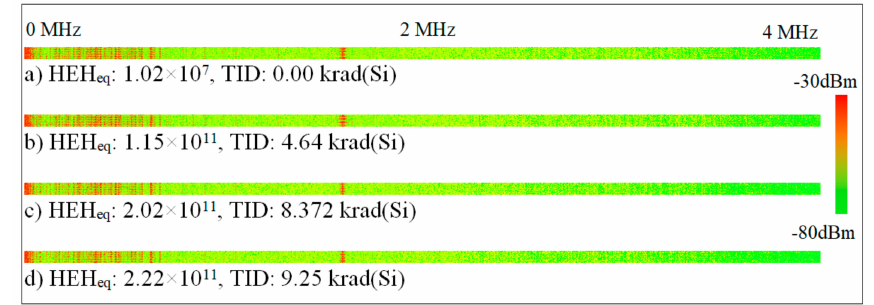
Figure 8. Waterfall fast frequency transformation (FFT) plot at 2.4 GHz center frequency on reception (RX) #1 of system under test (SUT) #1 for fluences (HEHeq) and TID